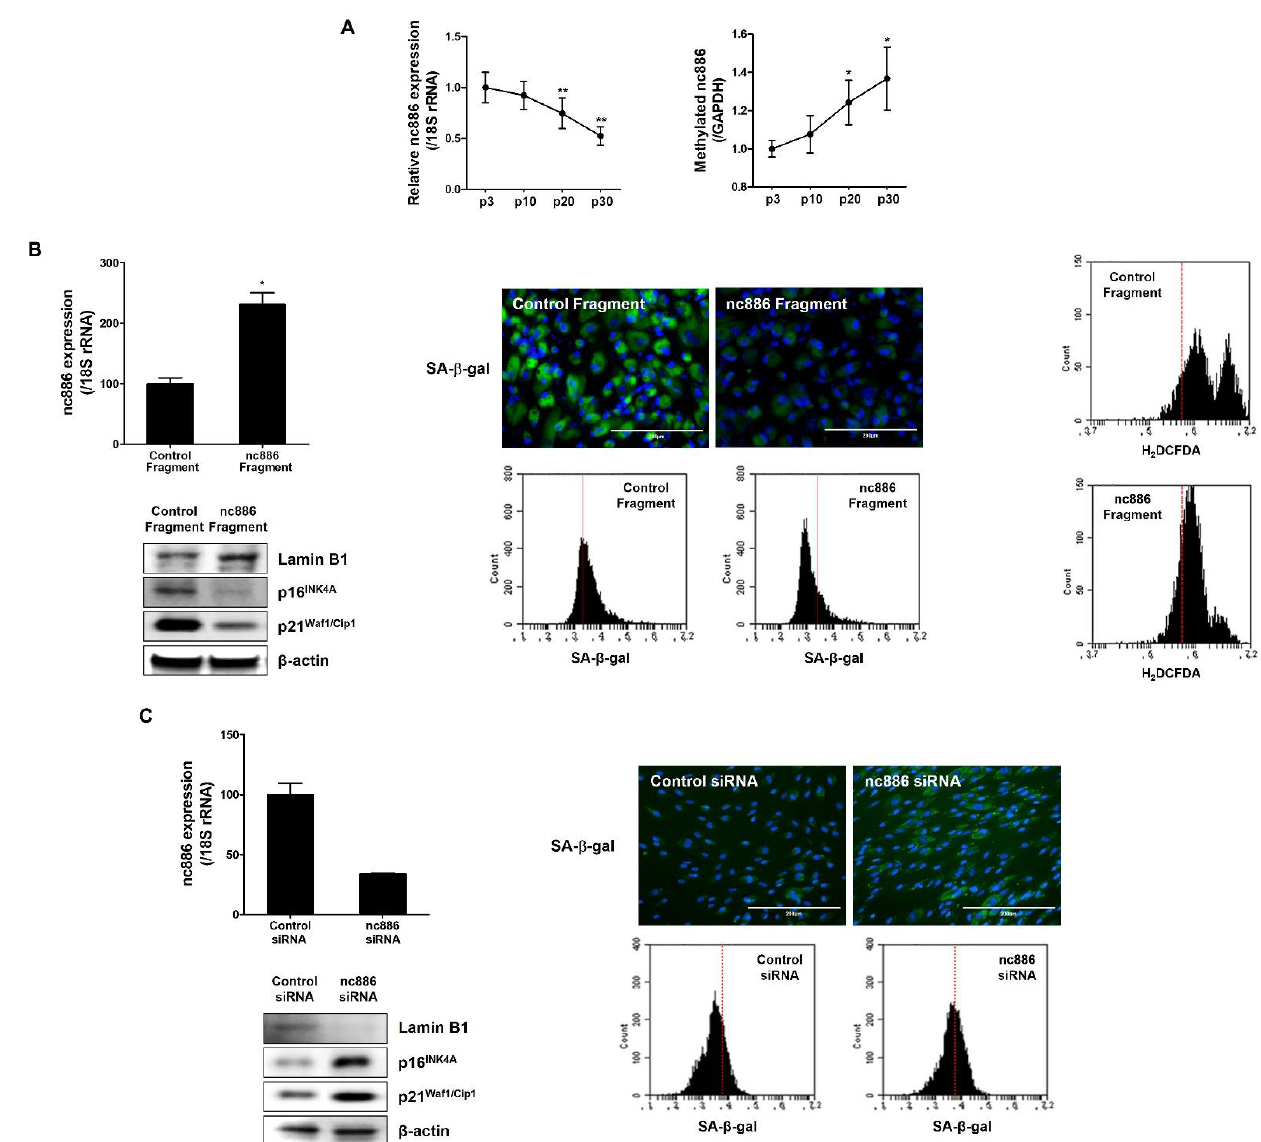
Figure 2. nc886 regulates cellular senescence of fibroblasts. ( A ) Expression of nc886 and methylated nc886 according to passage was confirmed by real-time PCR and normalized with 18s rRNA. ( B ) The nc886 fragment amplified and purified from human genomic DNA was transfected into senescent cells with Lipofectamine 3000. Overexpression was confirmed by observing the expression of nc886 by real-time PCR and SA-β-gal expression by fluorescence microscopy and flow cytometry. Expression of senescence marker protein and intracellular ROS generation were observed in nc886 overexpression model. ( C ) Cells were transfected with anti-oligos (si-ctrl and si-nc886) at a concentration of 250 ppm using Lipofectamin TM RNAiMAX reagent. nc886 knock-down was confirmed by observing the expression of nc886 by real-time PCR and SA-β-gal expression by fluorescence microscopy and flow cytometry. The expression of senescence markers was confirmed with western blot. Scale bars: 200 μm. Data are presented as mean ± SD of three independent assays. *, p < 0.05; **, p < 0.01 compared to control.